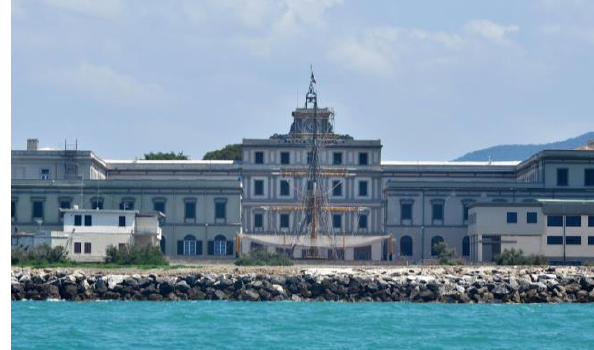
Figure 3 . The old building “Palazzo Allievi”